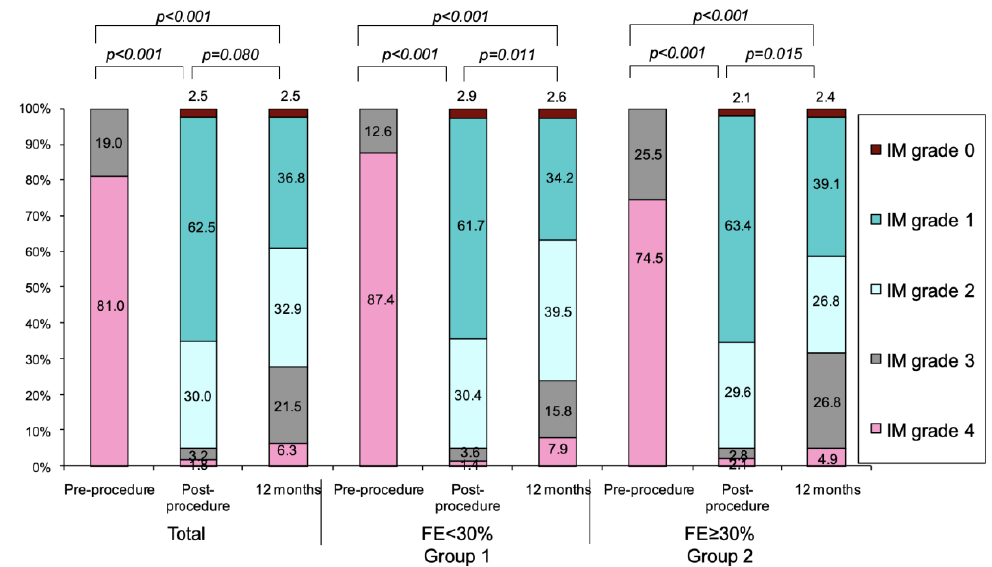
Figure 4. Changes over time in mitral regurgitation (MR) grade during follow-up in the entire series and according to LVEF groups. MR, mitral regurgitation.